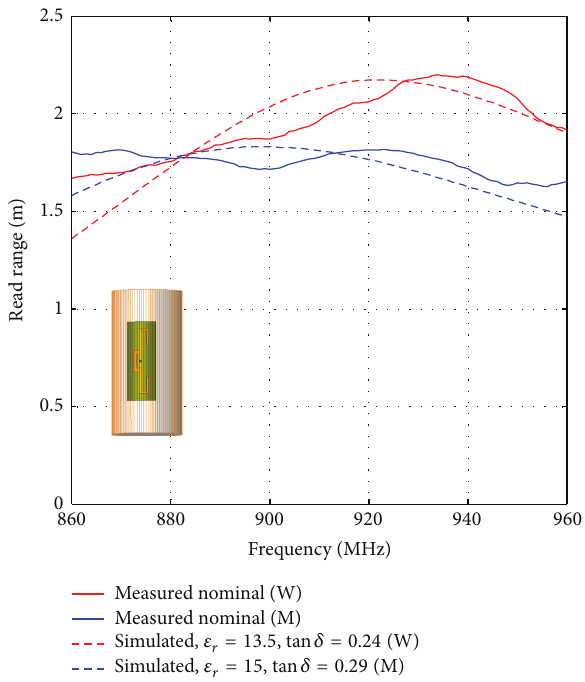
Figure11:Measuredandsimulatedreferencetagonhumanarmand human arm model, respectively.